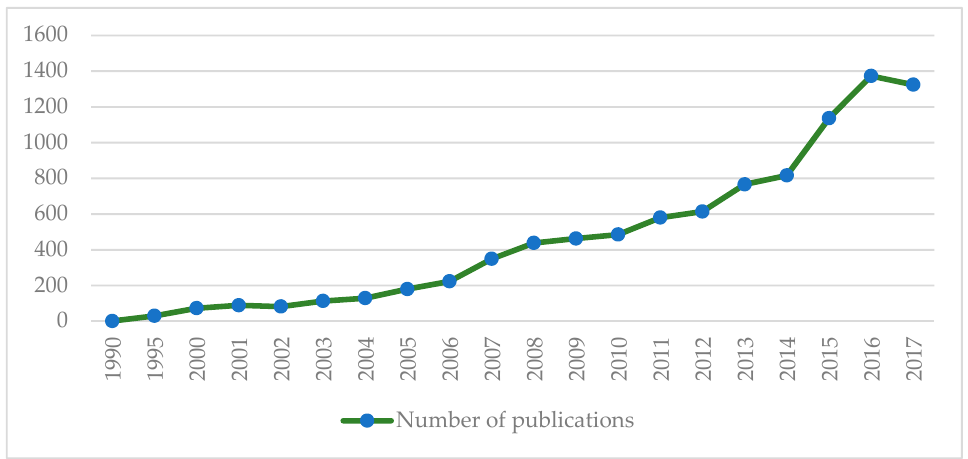
Figure 4. The publications on the topic of “multi-criteria decision making”, 1990–2017.